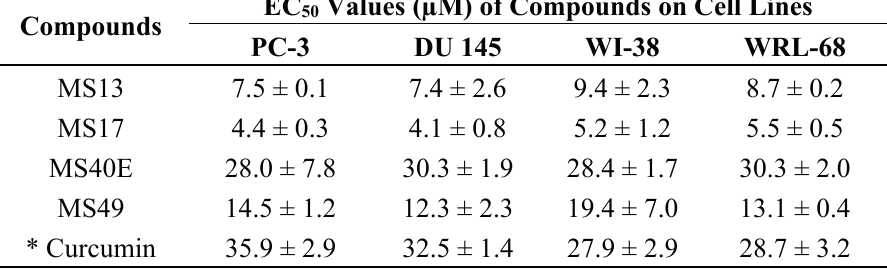
Figure 3. The inhibitory effects of cell viability by curcumin, MS17, MS13, MS40E and MS49 in DU 145 cell line compared to untreated sample (Ctrl). Results are expressed as means ± S.E. from three independent experiments. Percentage cell viability and comparison between data sets performed using ANOVA. ** p < 0.01 and *** p < 0.001 indicates statistically significant differences between the means of values obtained with treated vs. untreated cells. Table 1. EC 50 values of curcumin and its analogues on prostate cancer cell lines (PC-3 and DU 145) and normal cell lines (WI-38 and WRL